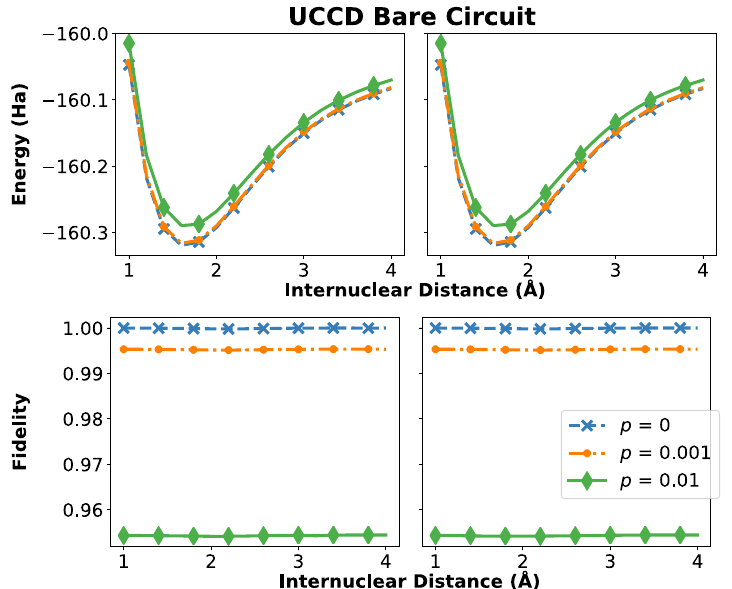
Fig. 2 The top row presents the ground state electronic energy of NaH using the UCCD bare circuit ansatz within the VQE method with different levels of depolarizing noise, p . The bottom row presents the corresponding fidelity of the prepared quantum state and that of the ground state found through conventional means. The left and right columns differentiate the results found using the COBYLA and L-BFGS optimizers,